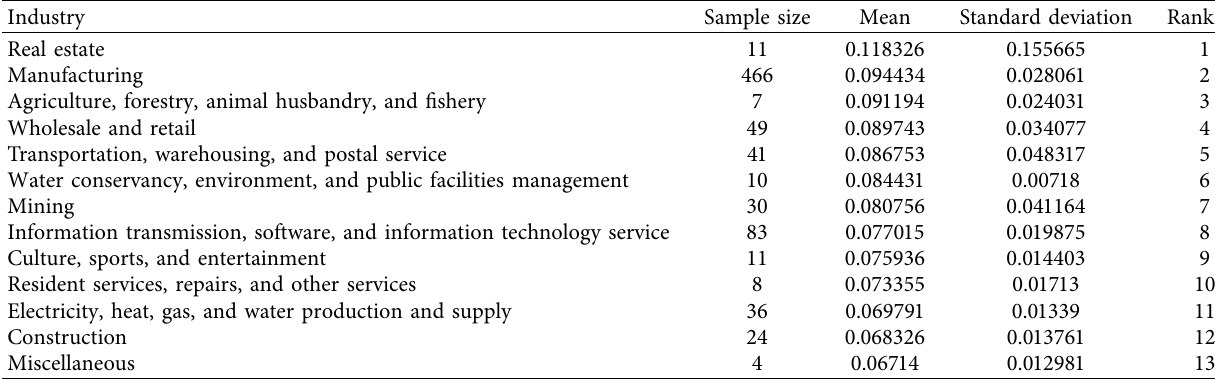
Table 4: Index weights and rankings of various